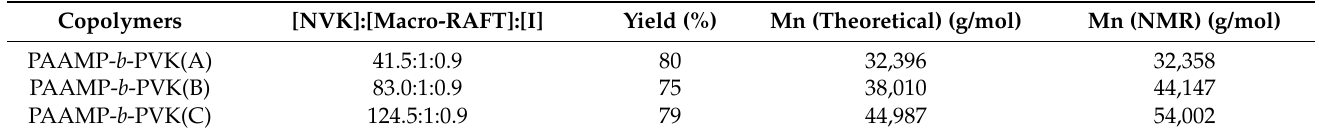
Table 3. Comparison of theoretical molecular weight (Mn) versus Mn calculated using